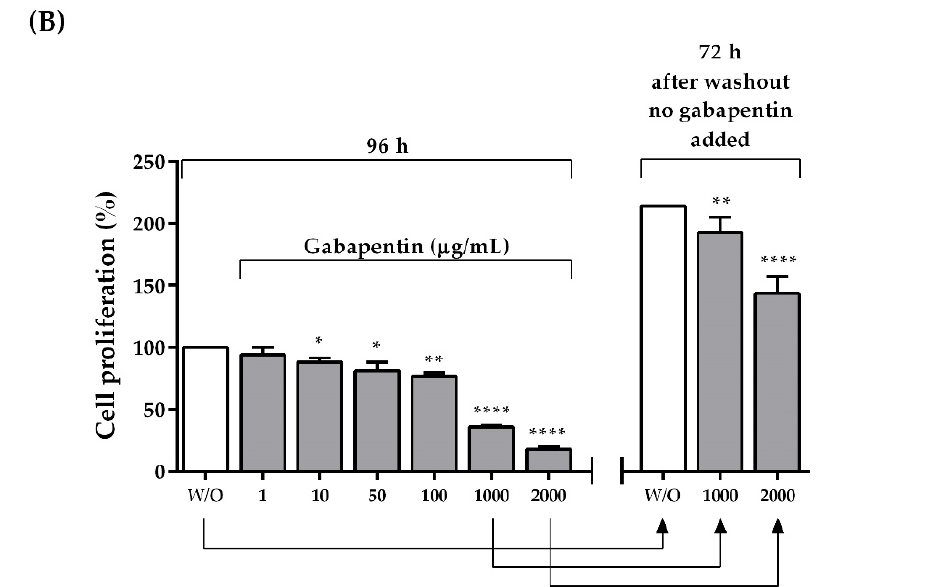
Figure 5. Cell proliferation: ( A ) Representative inverted fluorescent microscope images (200×) of the melanoma cell line B16–BL6/Zs green incubated for 96 h under different gabapentin doses (10, 100, 1000, or 2000 μ g/mL). ( B ) Proliferation assay using MTT to verify viability. The results are expressed as a percentage of cellular proliferation after 96 h of incubation with different doses of gabapentin (1, 10, 50, 100, 1000, or 2000 μ g/mL) compared with non-treated cells (100% proliferation), and after 72 h of gabapentin washout (no additional gabapentin added). Each column represents the mean ± SEM of the sample. * p ≤ 0.05, ** p = 0.0046, **** p < 0.0001.